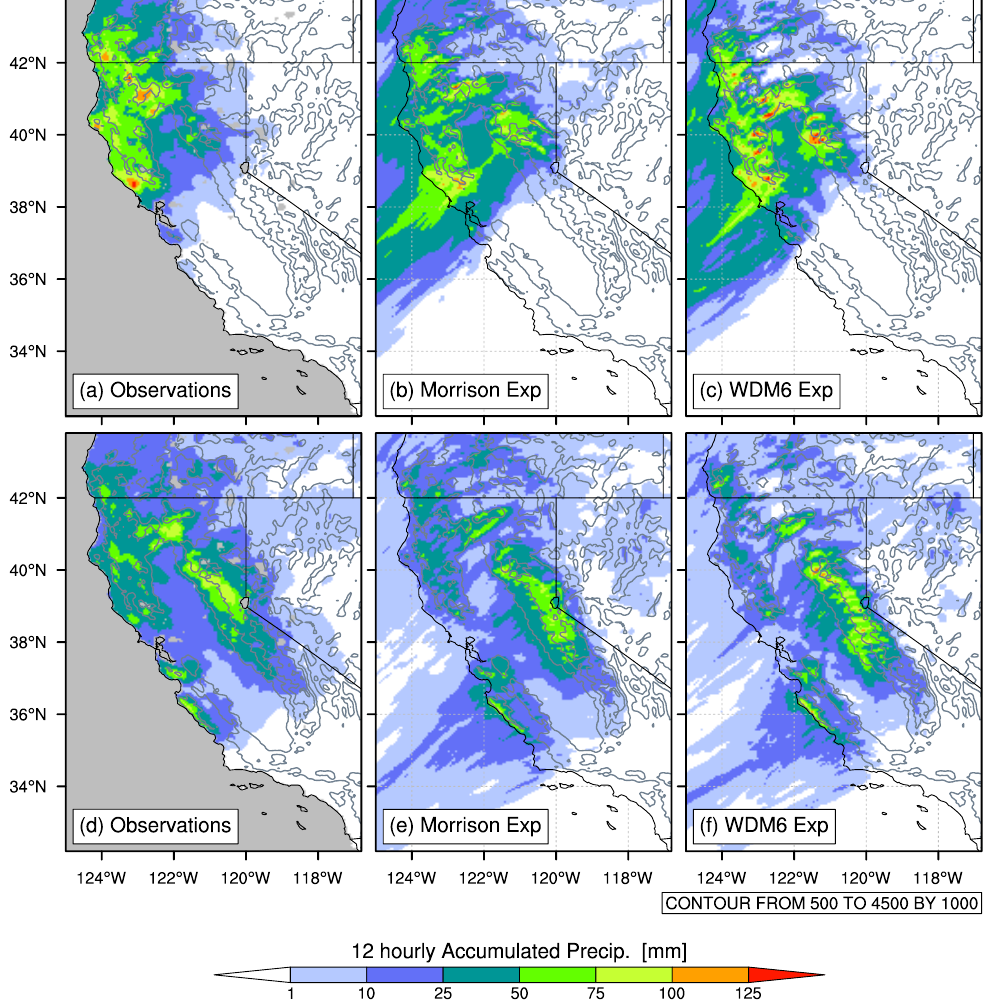
Figure 7. Total accumulated precipitation (shaded, mm) over the 12 h period starting at ( a – c ) 12:00 UTC 6 February 2015 and ( d – f ) 00:00 UTC 7 February 2015. The source of the precipitation is (a,d) gridded observations over the land, (b,e) the Morrison numerical experiment, and (c,f) the WDM6 numerical experiment. The height of the topography used in the numerical model is overlain (gray contours, m above sea level) and missing values are indicated by gray